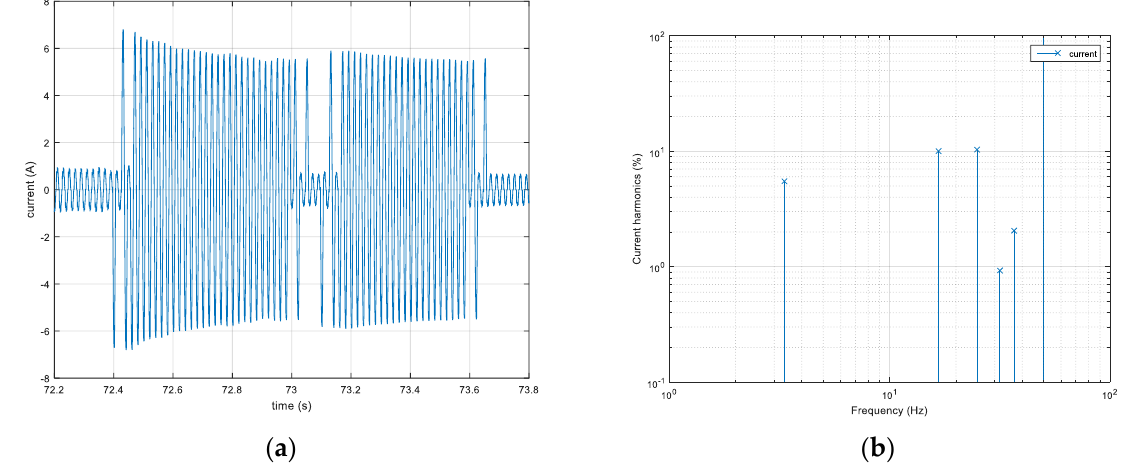
Figure 6. ( a ) Typical current waveform during the office printer copying cycle and ( b ) Harmonic analysis of the current at the end of the cycle, with significant subharmonic components up to 50 Hz.